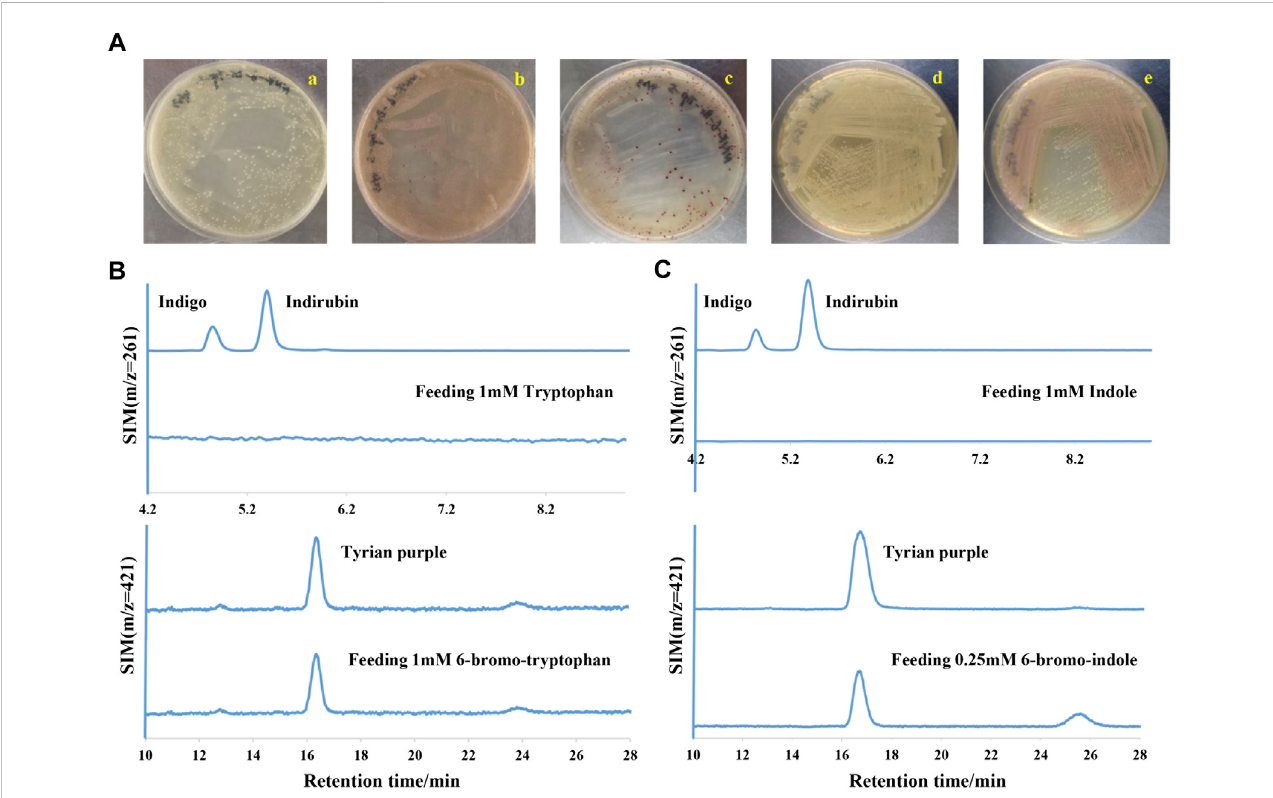
FIGURE 2 Tyrian purple can be selectively producedin GS-2. (A) GS-2grown on the LBagar platessupplemented with differentsubstrates: a. 1 mM Tryptophan; b. 1 mM 6-chloro-tryptophan; c. 1 mM 6-bromo-tryptophan; d. 1 mM Indole; and e. 0.25 mM 6-bromo-indole. (B) Extracted ion chromatograms for standards (the upper) of indigo (m/z = 261), indirubin (m/z = 261), Tyrian purple (m/z = 421), and colonies (the lower) were collected from GS-2 grown on the LB agar platessupplementedwithtryptophanor6-bromo-tryptophan,respectively. (C) Extractedionchromatogramsforthestandards(theupper)ofindigo(m/ z = 261), indirubin (m/z = 261), Tyrian purple (m/z = 421), and colonies (the lower) were collected from GS-2 grown on the LB agar plates supplemented with indole or 6-bromo-indole,